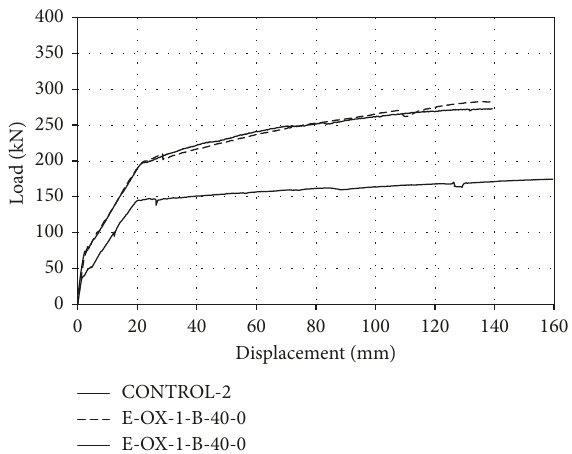
Figure 22: Strengthening effect w.r.t. matrix strength.